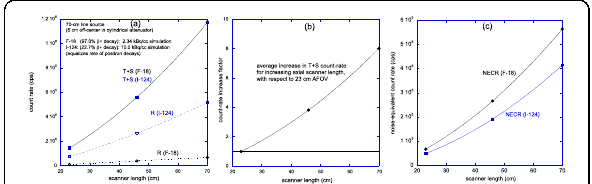
Fig. 1 (abstract A24). Simulated count-rate performance for a 70-cm-long NEMA line source, containing either 18 F or 124 I and